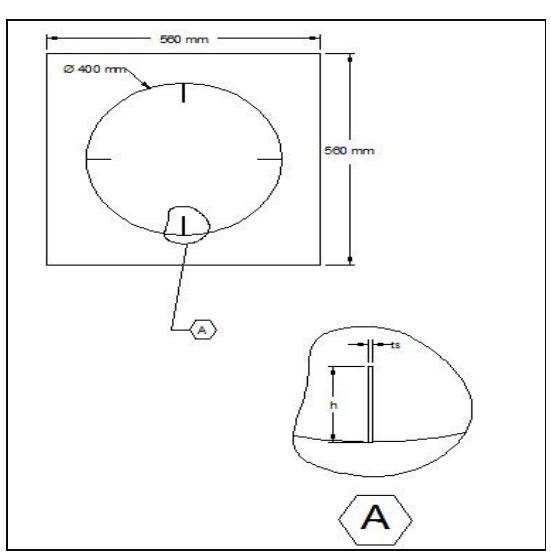
Fig. 2. the detail of stiffener